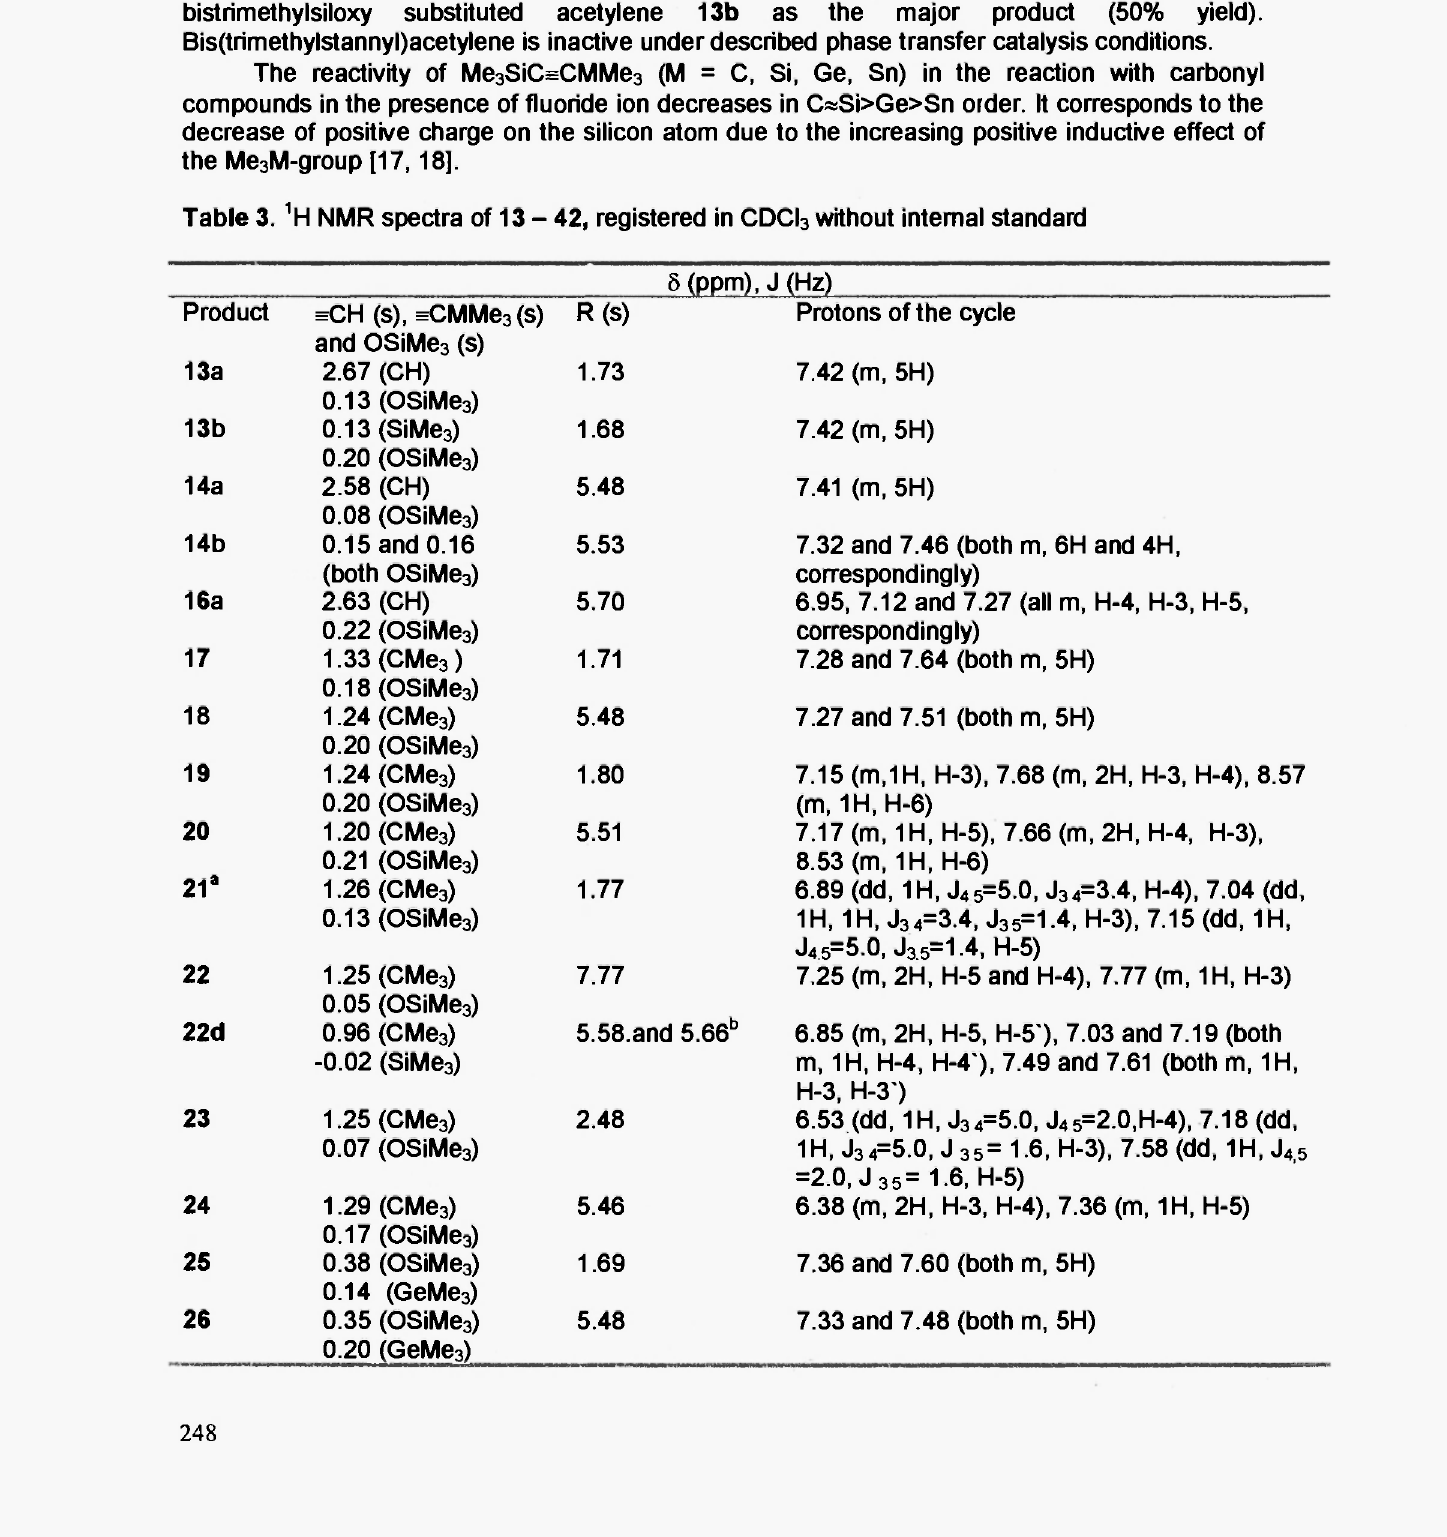
Table 3. 1 H NMR spectra of 13 - 42, registered in CDCI